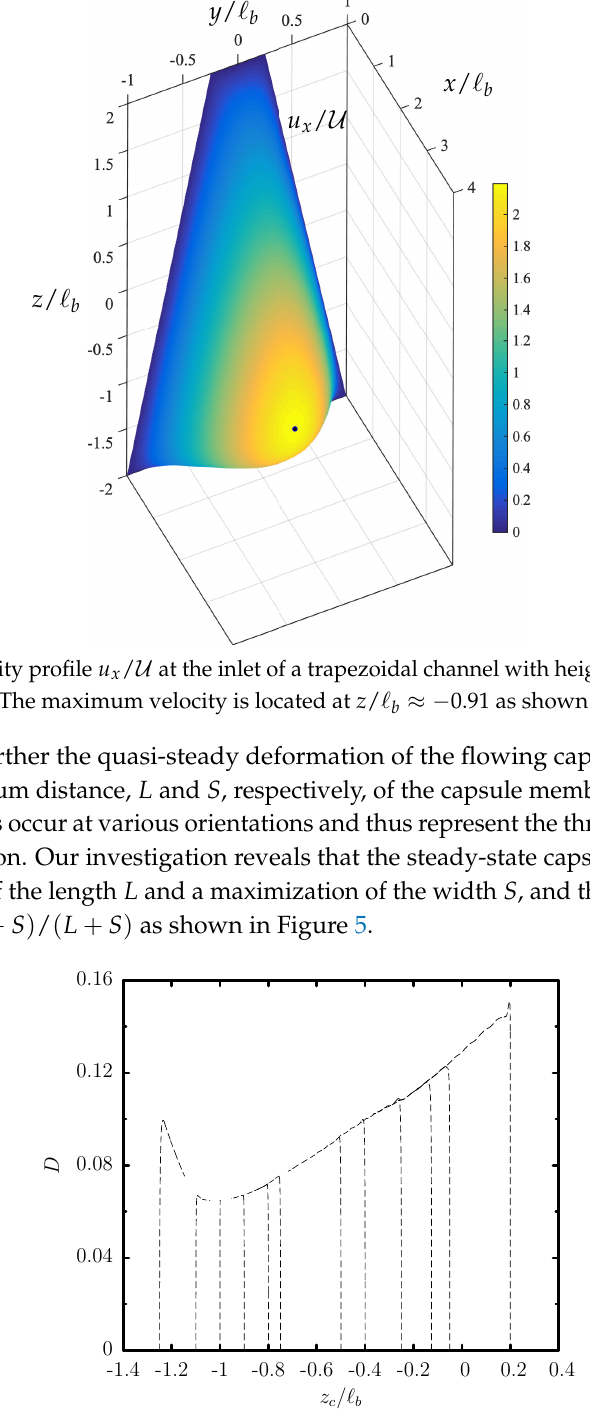
1.25,0.2 ] , flowing in a trapezoidal channel − S ) / ( L + S ) , where L and S are the maximum −